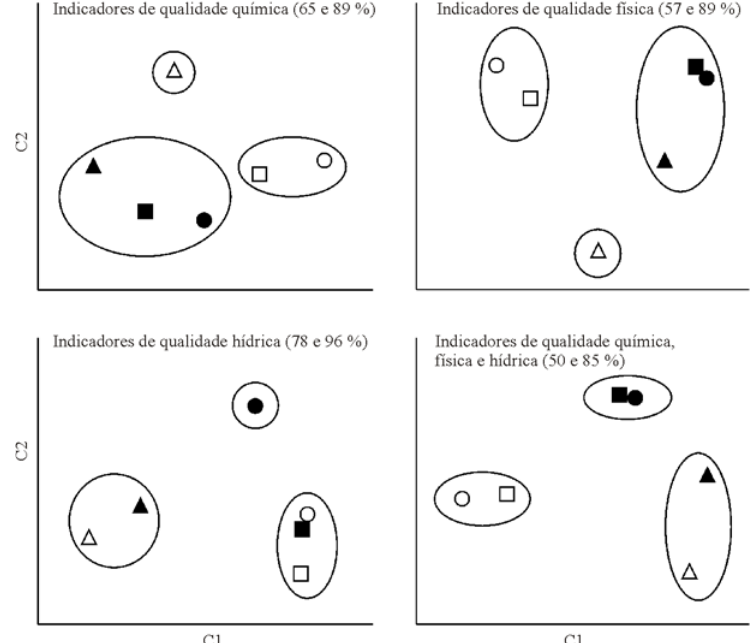
Figura 2. Dispersão dos indicadores de qualidade química, física e hídrica por posição de amostragem e camada de solo em relação aos dois primeiros componentes principais (C1 e C2) agrupados pelo método de Tocher (círculos e elipses), para um Latossolo Vermelho distrófico cultivado com laranjeira Valência.